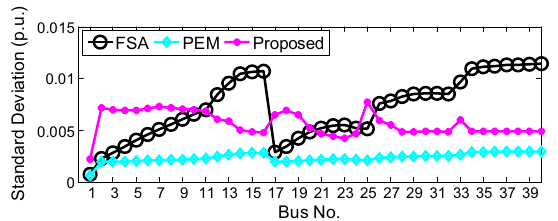
Fig. 12 Standard deviation of the PQ bus voltages